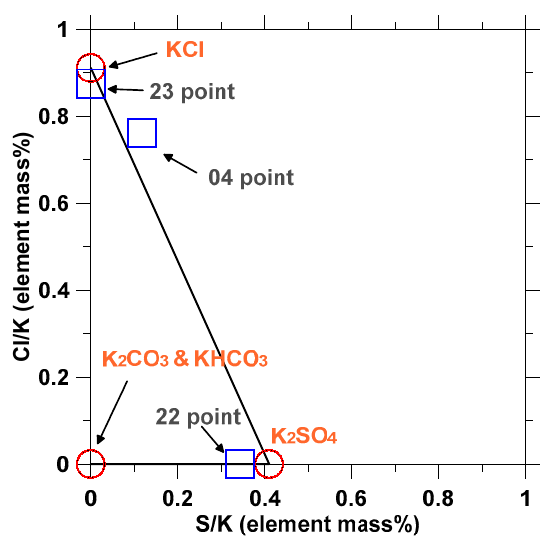
Figure 15. Element ratio based on analysis of EDS data.